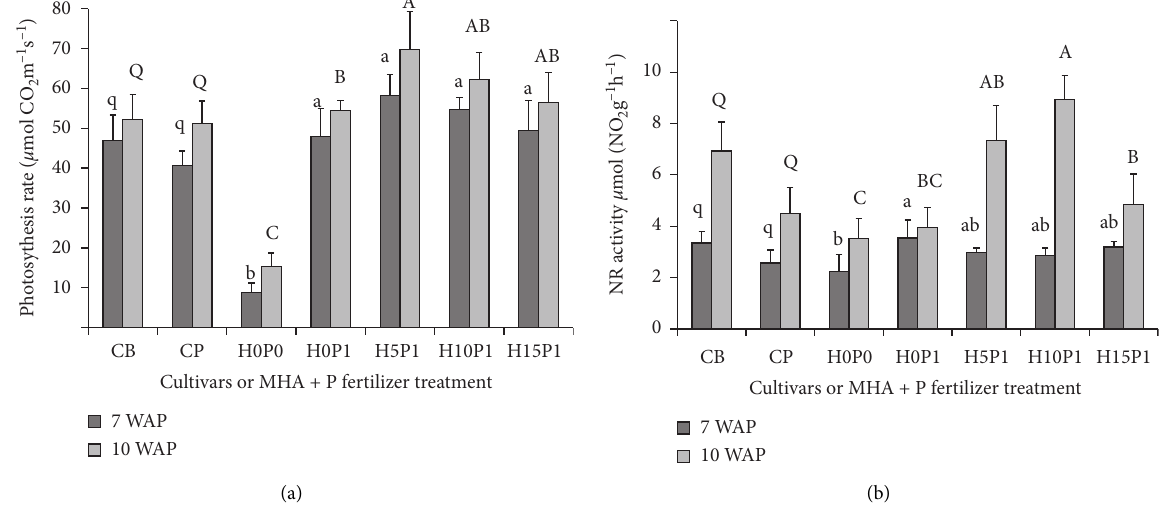
Figure 3: Photosynthesis rate (a) and nitrate reductase (NR) activity (b) of corn at 7 and 10 weeks after planting (WAP). CB is Bisi 2 hybrid corn, CP is Pioneer 35 hybrid corn. H 0 P 0 is the control, H 0 P 1 is 0mg kg − 1 composted manure (MHA)+P fertilizer, H 5 P 1 is combined 35mg kg − 1 MHA +P fertilizer, H 10 P 1 is combined 75mg kg − 1 MHA +P fertilizer, and H 15 P 1 is combined 110mg kg − 1 MHA+P fertilizer. The rate of P fertilizer in each P 1 treatment was equivalent to 120mg P 2 O 5 kg − 1 air-dried soil. Values followed by the same lowercase or uppercase letter in a column were not significantly different based on Duncan’s multiple range test at p < 0 . 05. The results presented are the mean+standard error of 3